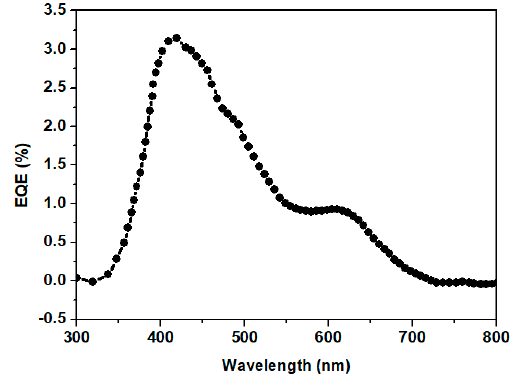
Figure 7. EQE characteristics of ZnPc/PEDOT:PSS/ITO device at 0 V.